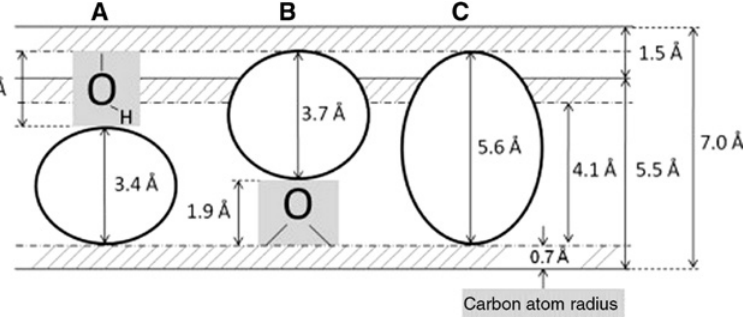
Figure 3: Schematic representation of the solvent intercalation in the GO interlayer and the maximum expansion obtained in our results